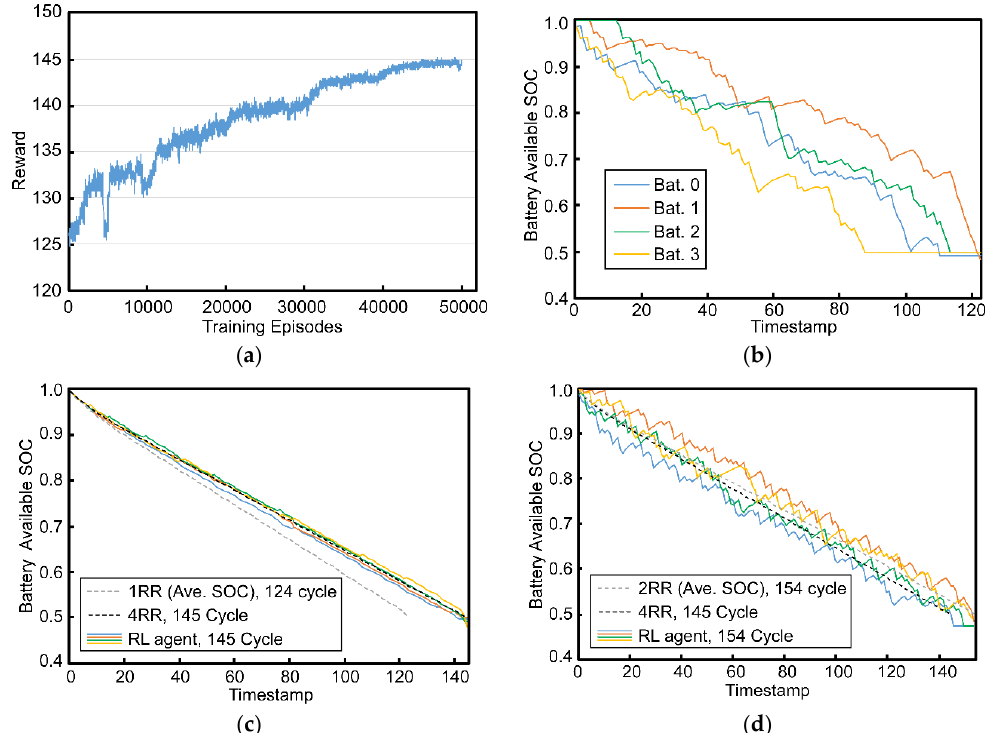
Figure 7. ( a ) Total reward during training, no temperature effect, discharge-only scenario. ( b )